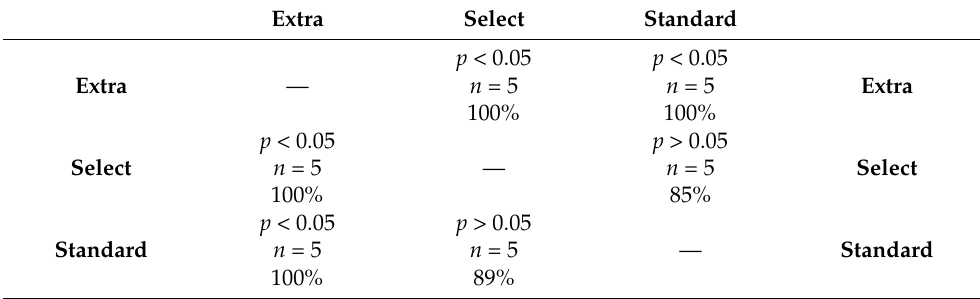
Table 1. Results of the triangular sensory analysis test for Californian-style black olives stuffed with hydrocolloids. Extra Select